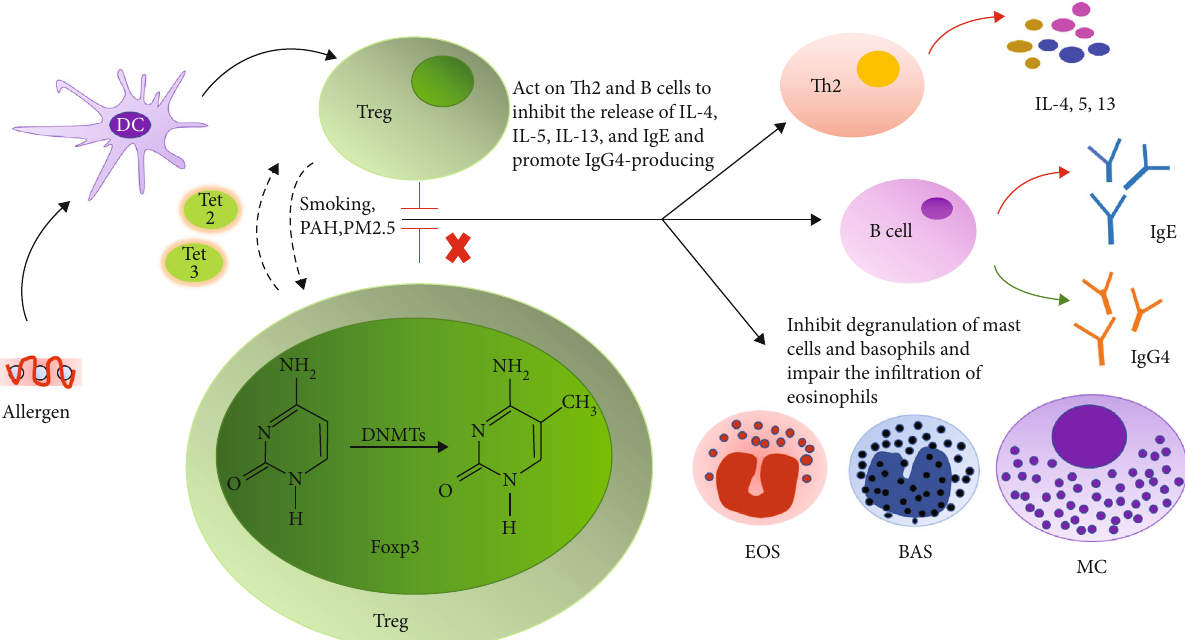
Figure 1: The role of Treg cells in the allergic response and the in fl uence of DNA methylation. Treg cells inhibit a multitude of allergic reactions induced by allergens. Treg cells can act on Th2 and B cells to block the release of in fl ammatory cytokines (e.g., IL-4, IL-5, and IL-13), IgE, and small molecules. Treg cells can also suppress mast cell and basophil degranulation and tissue in fi ltration by eosinophils, as well as promote the synthesis and release of IgG4 to relieve the immune response. Following exposure to smoke, PAH, PM2.5, and other factors, DNA methylation of Treg cells is modi fi ed, which alters the e ff ect of Treg cells on related immune cells and the allergic response. Finally, Tet2 and Tet3 work together to maintain demethylation of the Foxp3 gene in Treg cells, ensuring the stability of function.